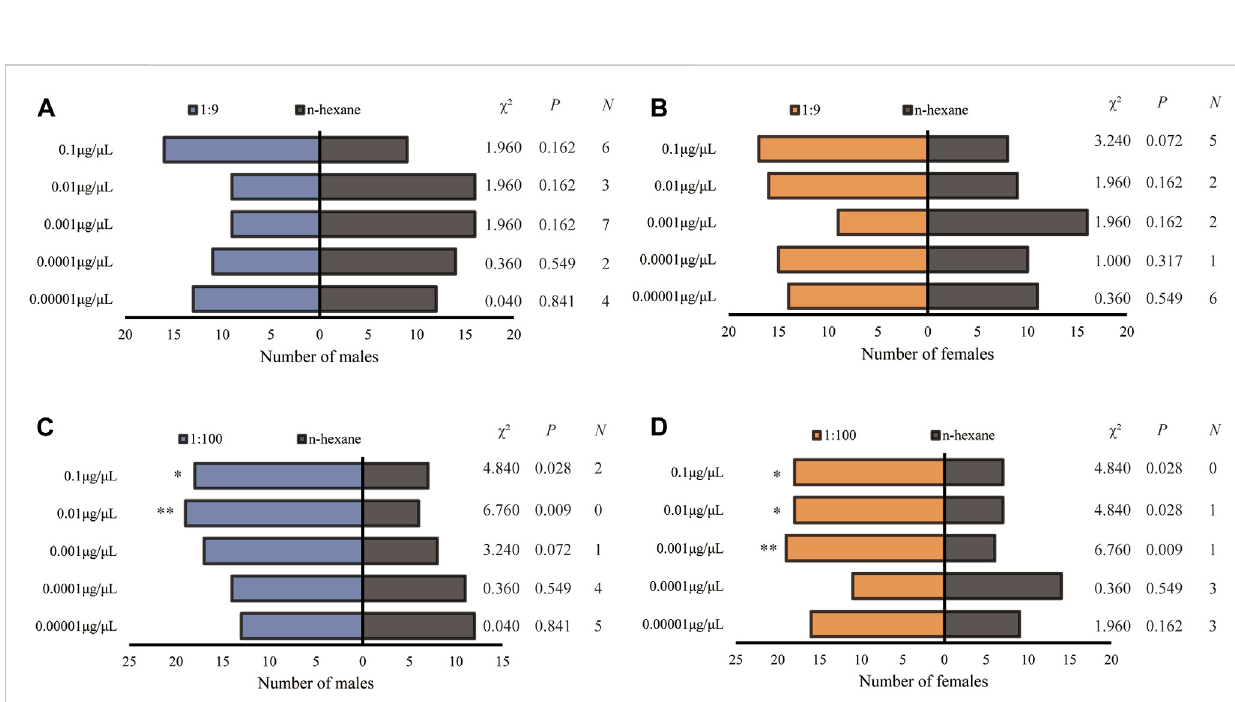
FIGURE 5 Olfactoryresponsesofmaleandfemale Harmoniaaxyridis totheblendofZ7-12:AcandZ9-14:Acattheratiosof1:9( (A) :male; (B) female)and1:100 ( (C) :male; (D) female)inaY-tubeolfactometer.Twenty- fi vefemalesormalesthatmadeachoice weretestedforeachtreatment.N:thenumberofnon- responses. The asterisks indicate signi fi cance differences at p < 0.05 (*) and p < 0.01